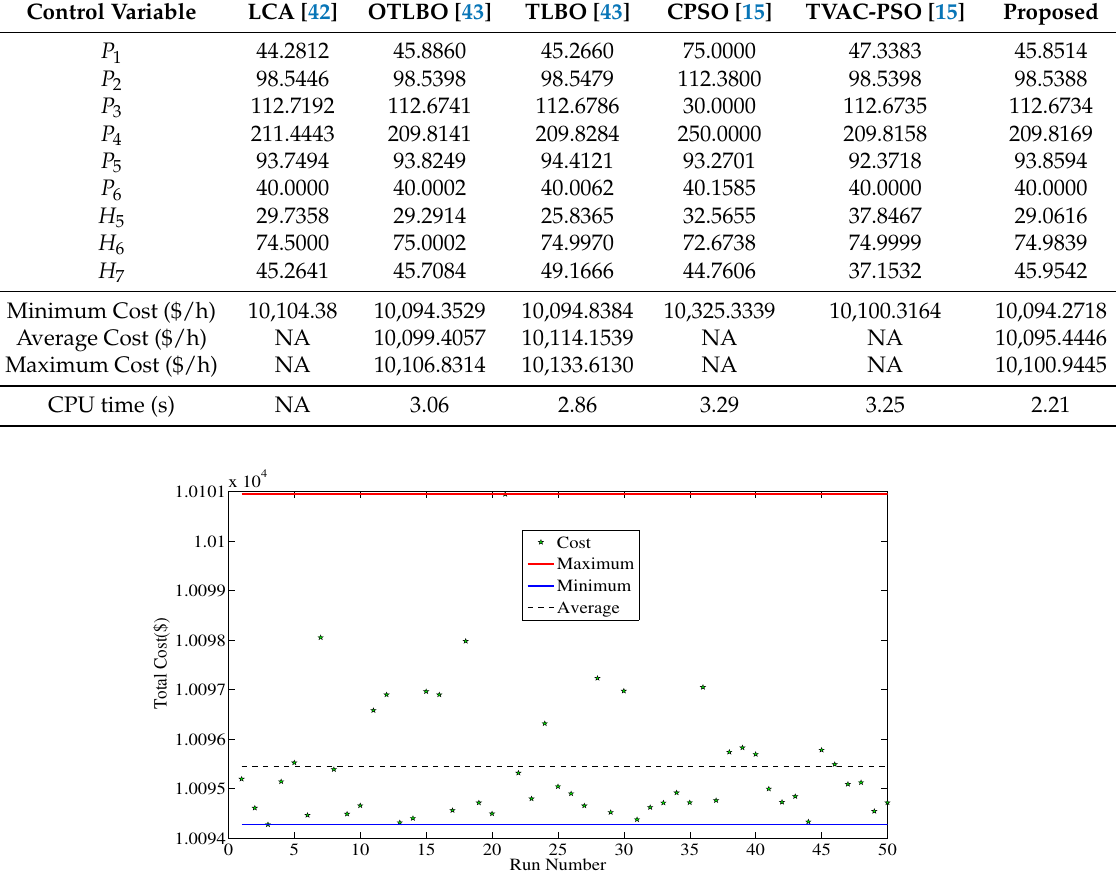
Table 7. Comparison of the obtained results for 7-unit test system (Case I).